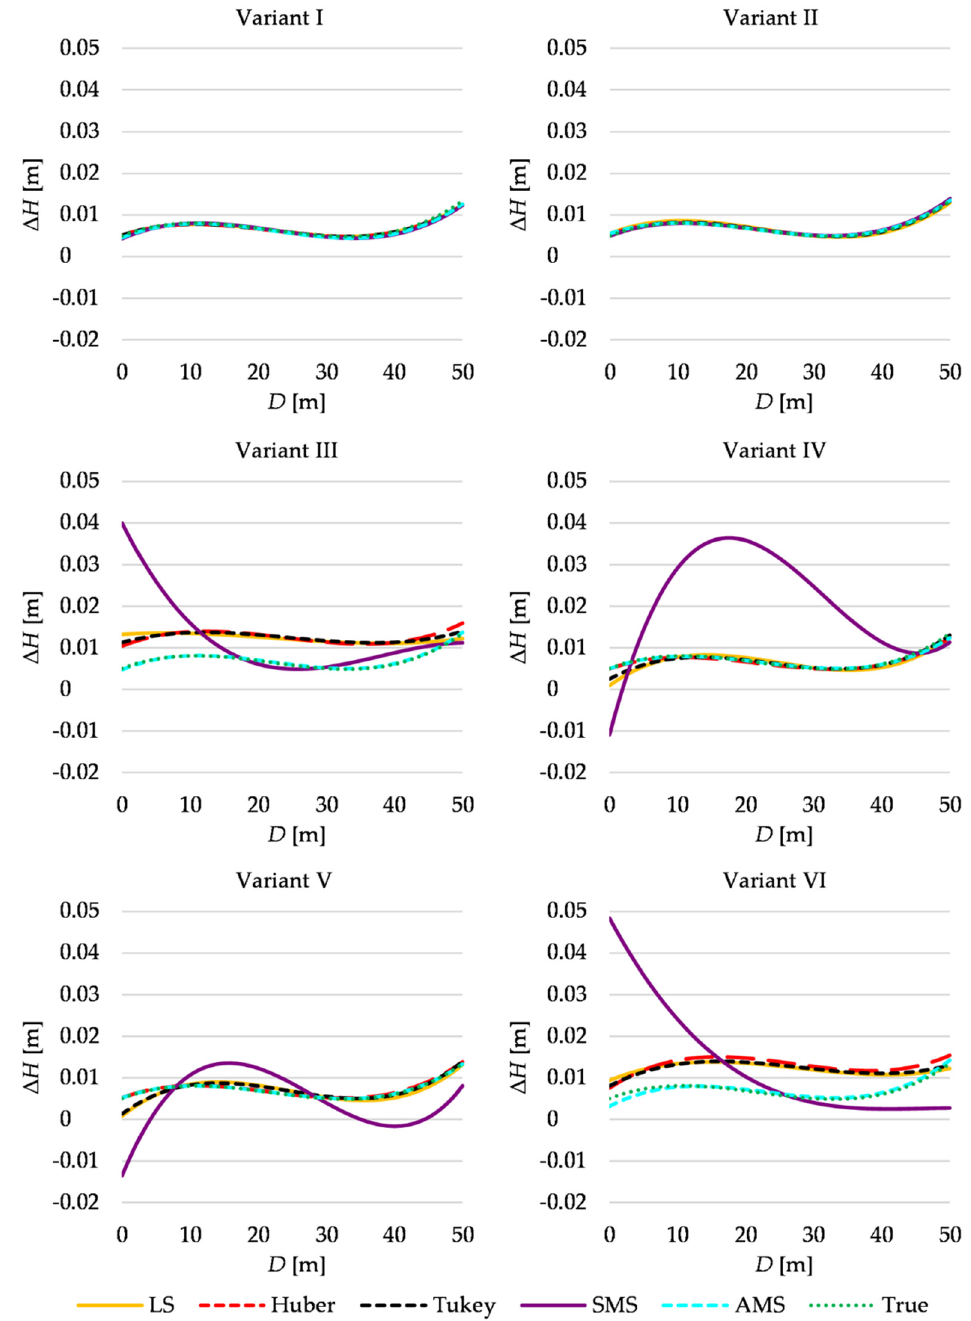
Figure 3. Estimated vertical terrain displacement for different variants.